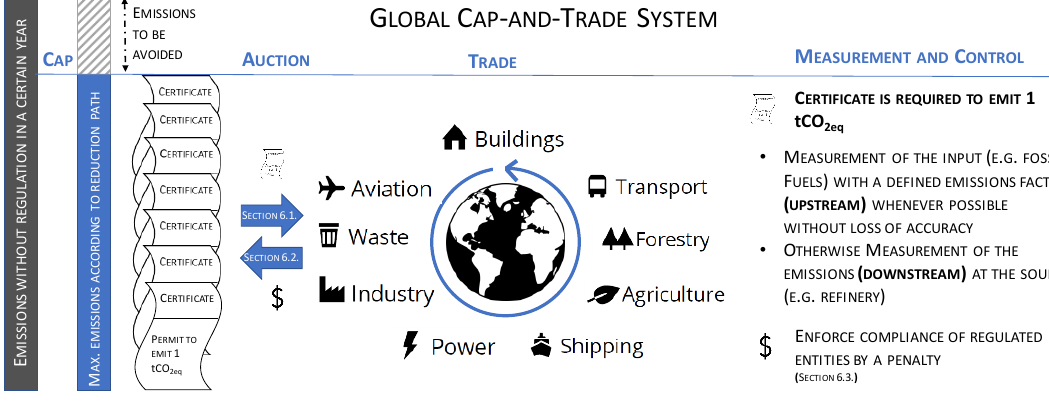
Figure 4. Derived political instrument―A global cap-and-trade system across all sectors.